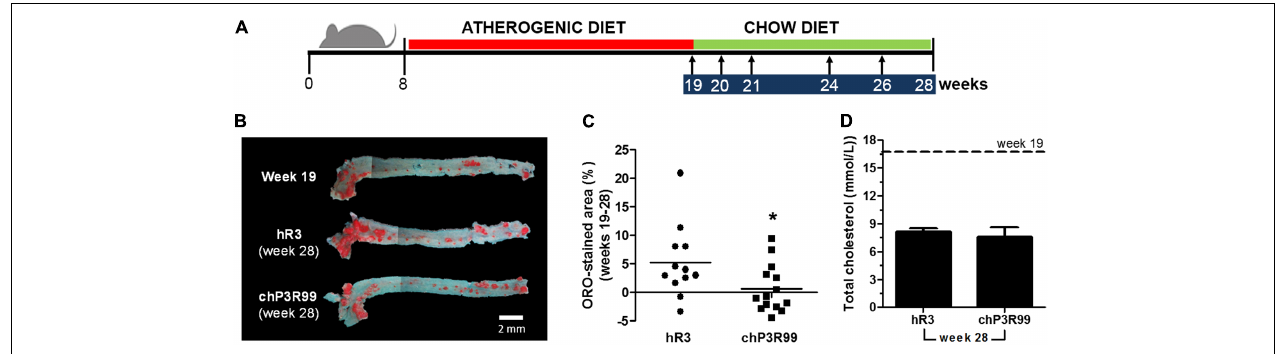
FIGURE 1 | Effect of a 5-dose administration schedule using chP3R99 in apoE − / − mice with advanced atherosclerotic lesions. (A) Experimental design. Red/Green and blue bars depict two different diet periods and administration schedule, respectively. Arrows indicate administration time points. (B) Representative en face Oil Red O-stained aortic arches and thoracic aortas from 19-week-old non-treated apoE − / − mice ( n = 11 in total) and 28-week-old apoE − / − mice treated with chP3R99 ( n = 14) or isotype-matched control hR3 ( n = 12). (C) Percent-aortic lesion areas (mean and individual) over baseline (week 19) in mice treated until week 28 with chP3R99 or hR3. (D) Total plasma cholesterol in apoE − / − mice at beginning (week 19, dashed line) and end (week 28, bar graphs) of treatment. Results are mean ± SEM of one representative of at least two independent experiments with similar results. ∗ represents p < 0.05 vs. isotype-matched control hR3, unpaired student’s t